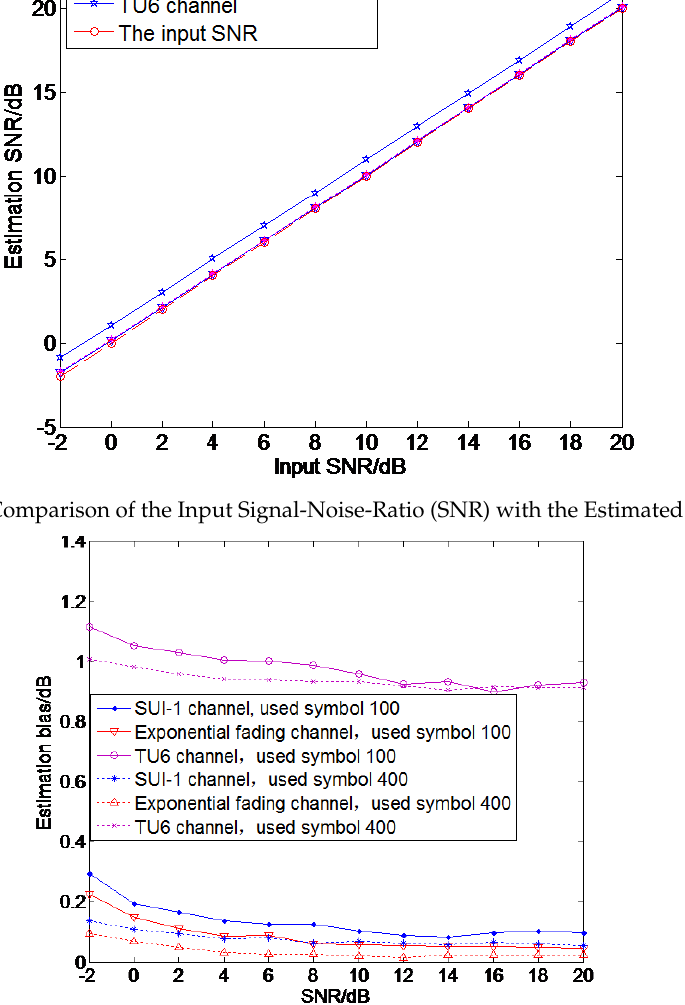
Figure 5. Estimation performance with different number of